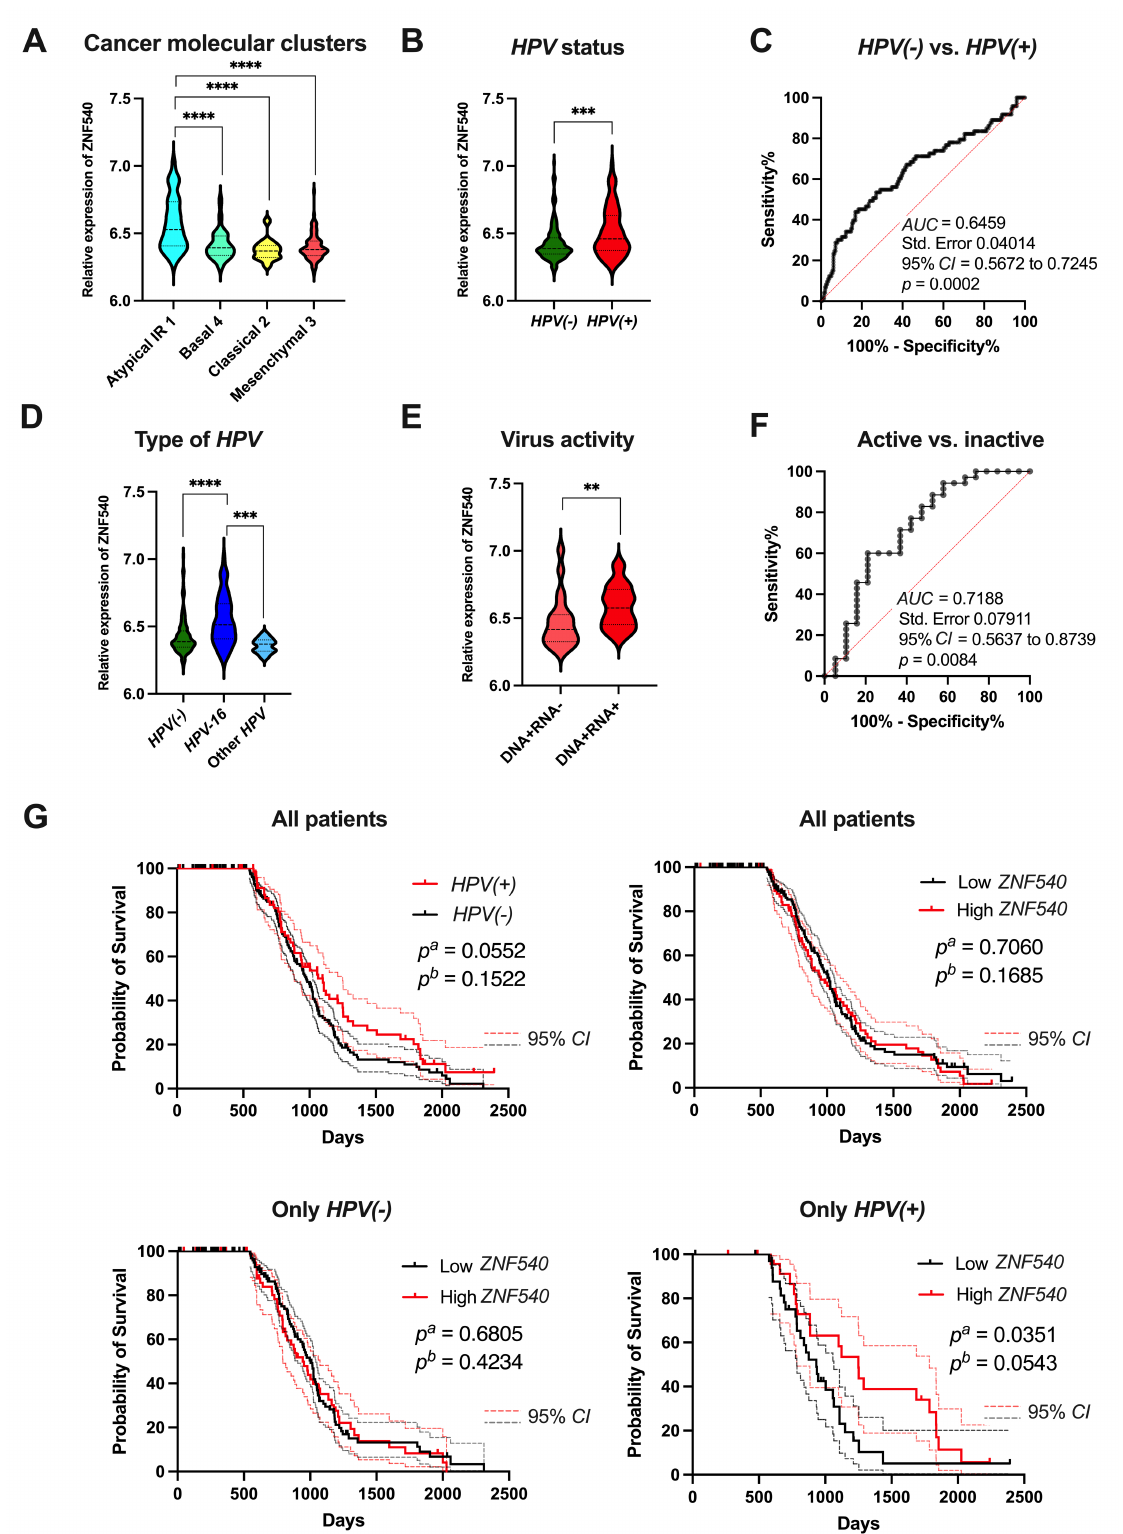
Figure 6. Validation of ZNF540 in HNSCC patients using GSE65858 dataset: ( A ) ZNF540 level in different types of HNSCC divided into cancer molecular clusters (atypical IR1, basal 4, classical